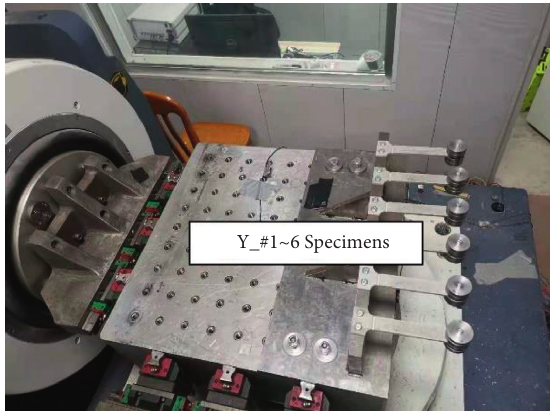
Figure 16: Original fatigue life test sample number. Table 4: Original fatigue life test